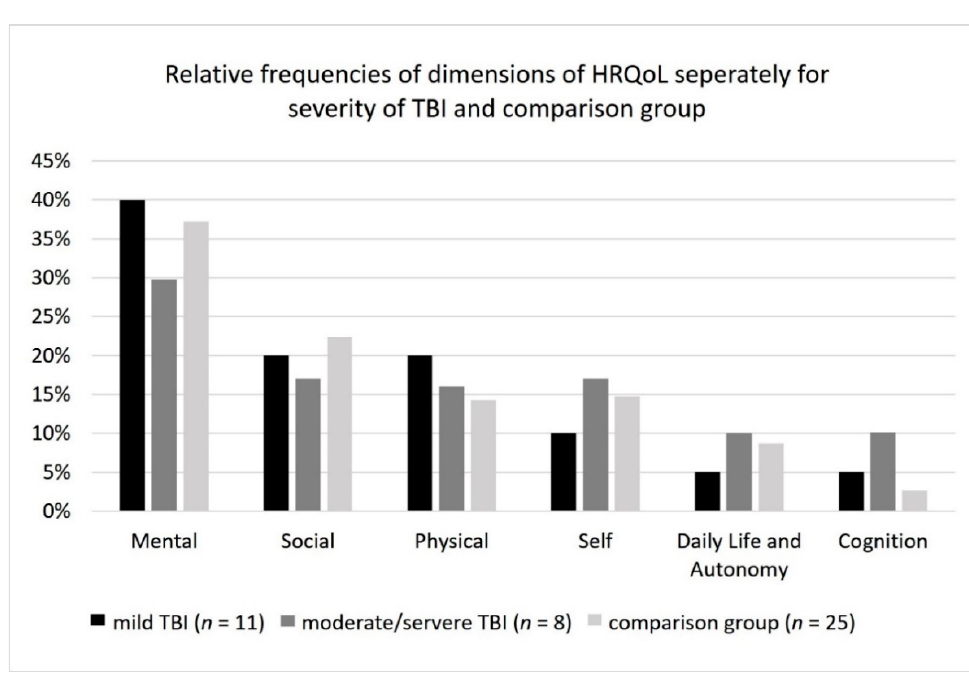
Figure 2. Relative frequencies of main dimensions of health-related quality of life (HRQoL) for mild traumatic brain injury (TBI), moderate to severe TBI, and comparison group.